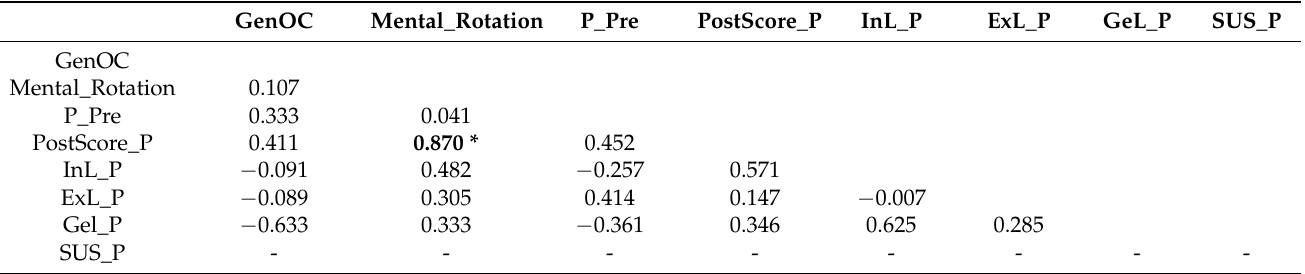
Table 7. Correlations for group one (NonAR) for the topic pericyclic reactions.